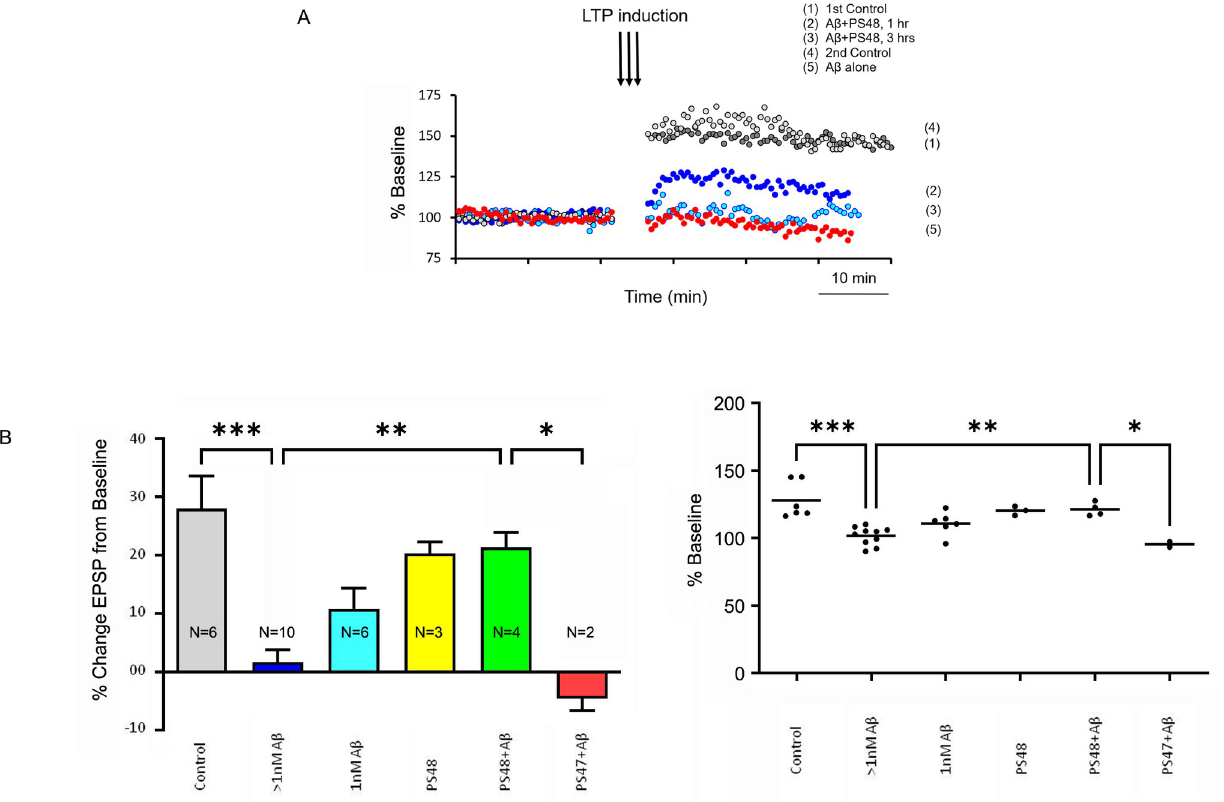
Fig 3. PS48 partly restores the suppression of LTP by A β 42. A . Day 14 rat prefrontal cortex (PFC) exposed to A β oligomers (0.5 μ M) or A β plus PS48 (10 μ M). Superimposed representative single recordings made under conditions 1 through 5, as noted. Control is DMSO-vehicle. EPSPs recorded from layer 2; stimuli (32 μ A = ½ max ampl., 2 Hz) applied to layer 5. A β completely suppressed LTP (5 vs. 1). PS48 in the prsence of A β restored 68 ± 18% of control potentiated EPSP (1 hour perfusion, condition 2). A 3 hour application however showed near complete run-down (3). A β and A β /PS48 experiments were restored to control LTP levels after washout (4). B . Quantification of LTP data. Bar graph (left). LTP induction shown as mean % change (increase or decrease) from baseline ( ± SEM). n independent replicates are noted. Scatter graph (right) gives means of individual experiments and group averages as unadjusted % baseline values (normalized at 100%). All concentrations A β > 1 nM (high dose, 2.5–500 nM) completely abrogated LTP. PS47 is an inactive isomer control (n = 2). n replicates as shown. ��� p < .0001 A β alone (high dose) vs control, �� p < .01 PS48 treatment vs A β alone (high doses), � p < .05 PS48 treatment vs. P47 control (A β high doses); ANOVA and Tukey’s tests (see text for additional statistical